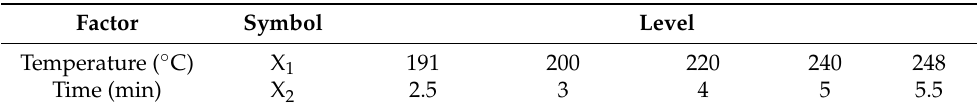
Table 1. Factors and their levels in the three points of central composite design for optimizing the SSR conditions of APR.